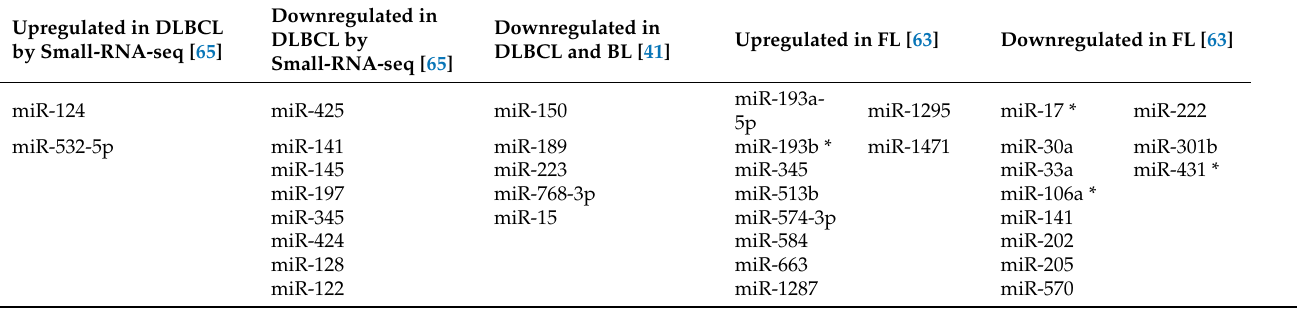
Table 5. lymphomiRs reported on different types and subtypes of